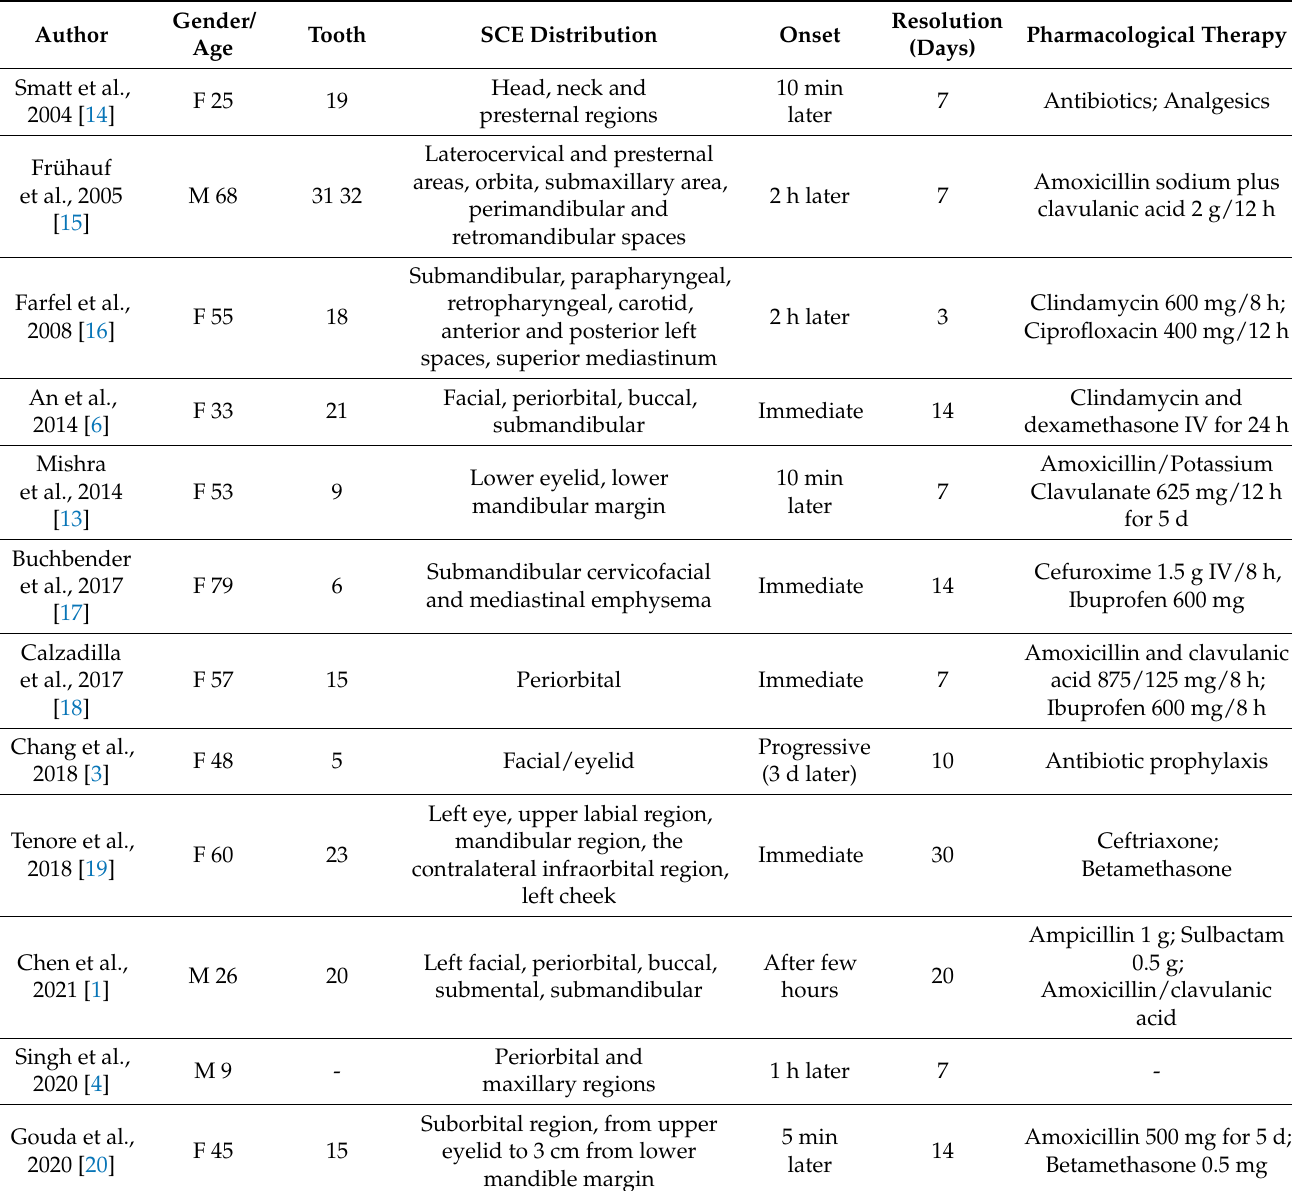
Table 1. Distribution of subcutaneous emphysema (SCE) during endodontic treatment in literature. IV: intravenous; h: hours; min: